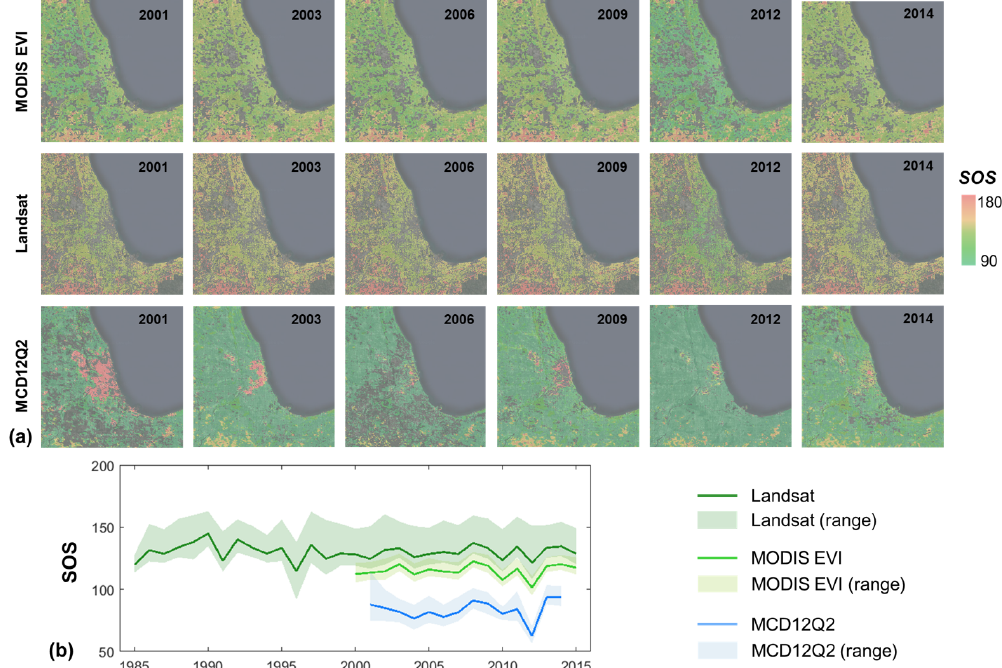
Figure 10. Annual start of season (SOS) derived from Landsat, the Moderate Resolution Imaging Spectroradiometer (MODIS) enhanced vegetation index (EVI), and MCD12Q2 in the Chicago metropolitan area in representative years (a) and the temporal trend at the regional level (b) . Solid lines are the mean SOSs at the regional level and shadowed frames indicate the range of SOS within the 25th and 75th quantile levels. Pixels without good fitting performance (i.e., the correlation coefficient is lower than 0.85) were removed in the derived SOS from Landsat and MODIS